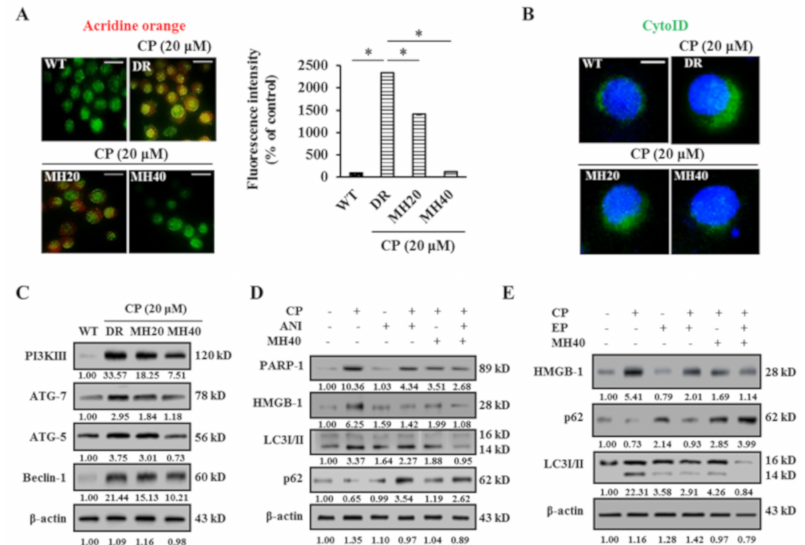
Figure 3. MH suppresses PARP1-mediated autophagy in HepG2 DR cells. ( A ) HepG2 WT and HepG2 DR cells were stained with the acridine orange (AO) dye after corresponding drug treatments and observed under a fluorescence microscope. Autophagosomes are indicated by red fluorescence (magnification: 400 × ; scale bar: 0.1 mm). Autophagy rate (% of control) was calculated using the ImageJ software (left panel). ( B ) Fluorescence images of HepG2 DR cells, showing autophagic acidic vesicles, were obtained by staining with the Cyto-ID ® autophagy reagent (green) after CP-MH treatments; the nucleus is stained with Hoechst 33342 (blue) (scale bar: 0.1 mm). ( C ) Expression levels of major autophagy-associated markers were analyzed by Western blotting using specific antibodies against PI3KIII, ATG7, ATG5, and Beclin-1 after treatment with CP-MH; results were normalized relative to β -actin. ( D ) Expression levels of cytosolic PARP1, HMGB1, LC3I / II, and p62 after treatment with CP, MH, and ANI, alone or in combination, were analyzed by Western blotting. Results were normalized relative to β -actin. ( E ) Expression levels of cytosolic HMGB1, p62, and LC3I / II were evaluated after treatment with CP, MH, and EP, alone or in combination. Results were normalized relative to β -actin. Relative intensities were measured by ImageJ software. At least two independent experiments were performed. * p < 0.05, ** p <